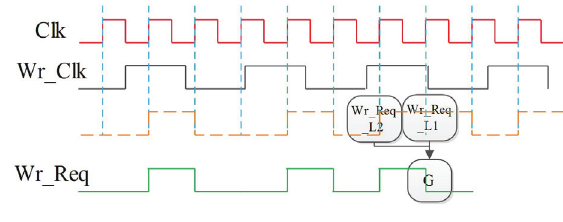
Fig. 9. Synchronized Sampling Singal.